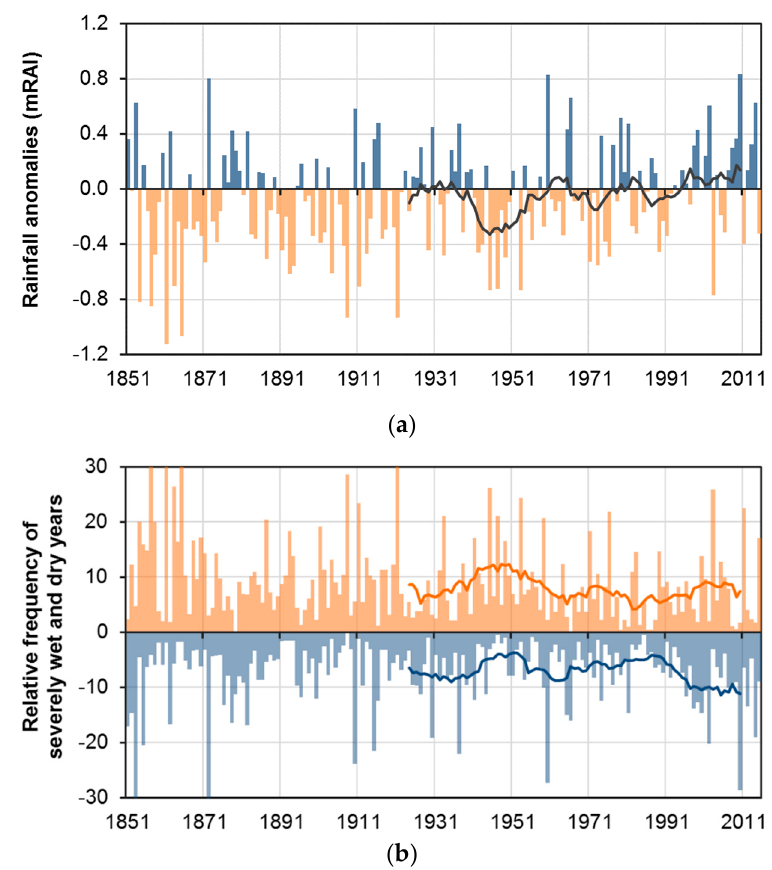
Figure 4. Time series (annual resolution) of European precipitation anomalies (average of at most 220 stations; for variations in the data availability please refer to Figure 1b) within 1851–2015. Additionally, the 11-year moving averages are shown. They only start in 1924, when all eight sub-regions have a data availability of at least 50%. Part ( a ) presents the annual rainfall anomalies (mRAI-12 for December; please note that here negative anomalies are connected to dry conditions) and part ( b ) the relative frequency of severely dry (percentage of stations with a mRAI < − 1.5) and wet years (percentage of stations with a mRAI > 1.5; please note that for illustration purposes the results for severely wet years are printed as negative values. Table 5. Absolute linear trends for Europe and its eight sub-regions (for region abbreviations please